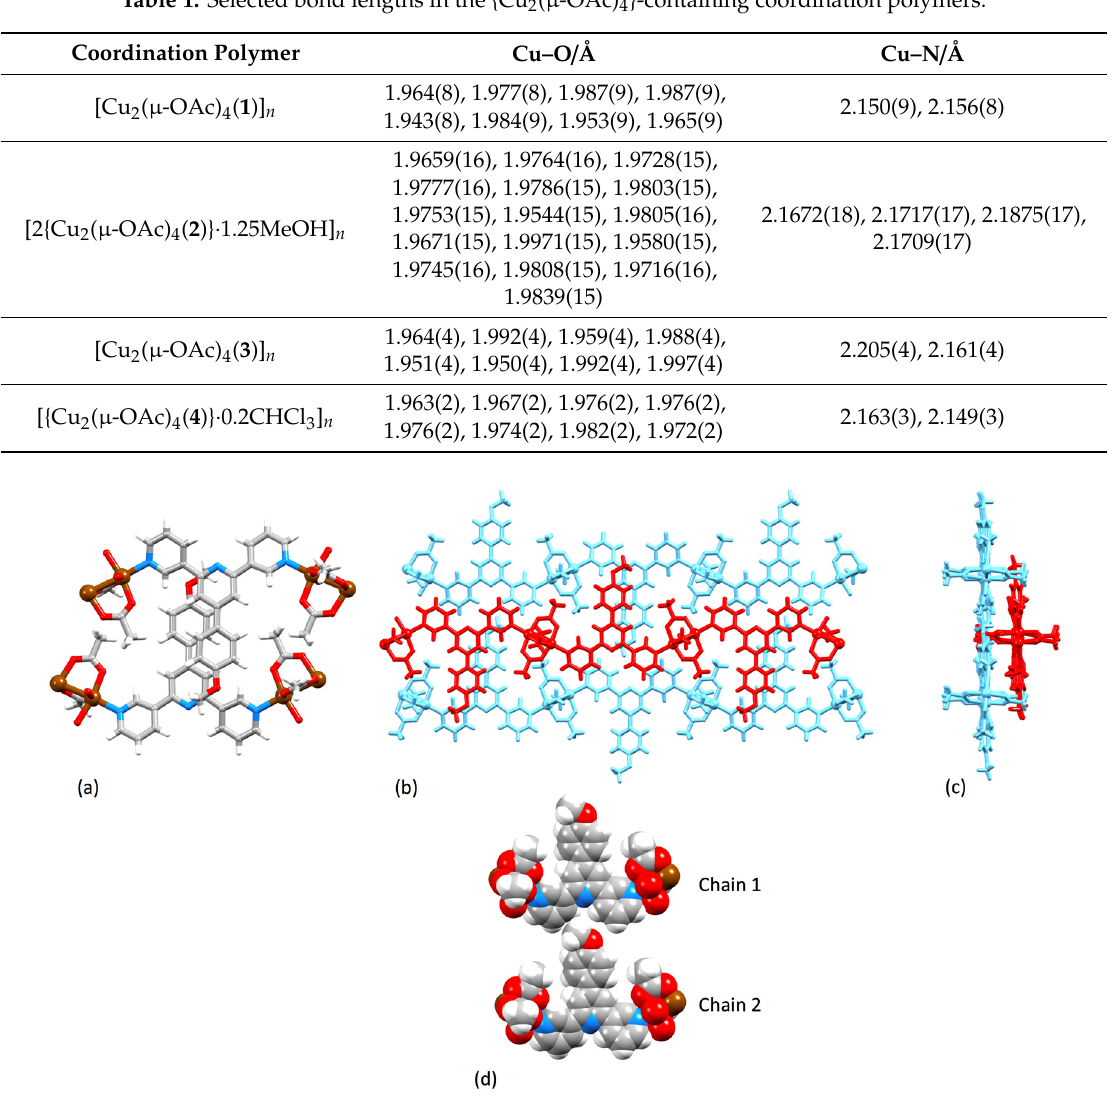
Figure 6. Packing in [Cu 2 ( µ -OAc) 4 ( 1 )] n : ( a ) Head-to-tail stacking of 4 (cid:48) -(4-methoxyphenyl)pyridine units in adjacent chains; ( b ) extended stacking interactions lead to the formation of 2D sheets – the red and blue chains lie in adjacent sheets; ( c ) an orthogonal view of diagram ( b ) showing the accommodation of acetato ligands in cavities in the adjacent sheet; ( d ) accommodation of a methoxy group in one chain in the pocket of a 3,2 (cid:48) :6 (cid:48) ,3”-tpy domain in an adjacent chain.